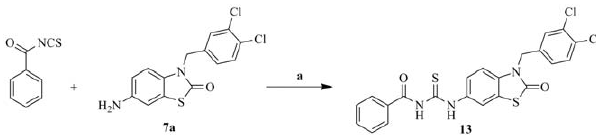
Figure 14. Synthesis of target compound (13). Reagents and conditions: (a) CH 2 Cl 2 , r.t,